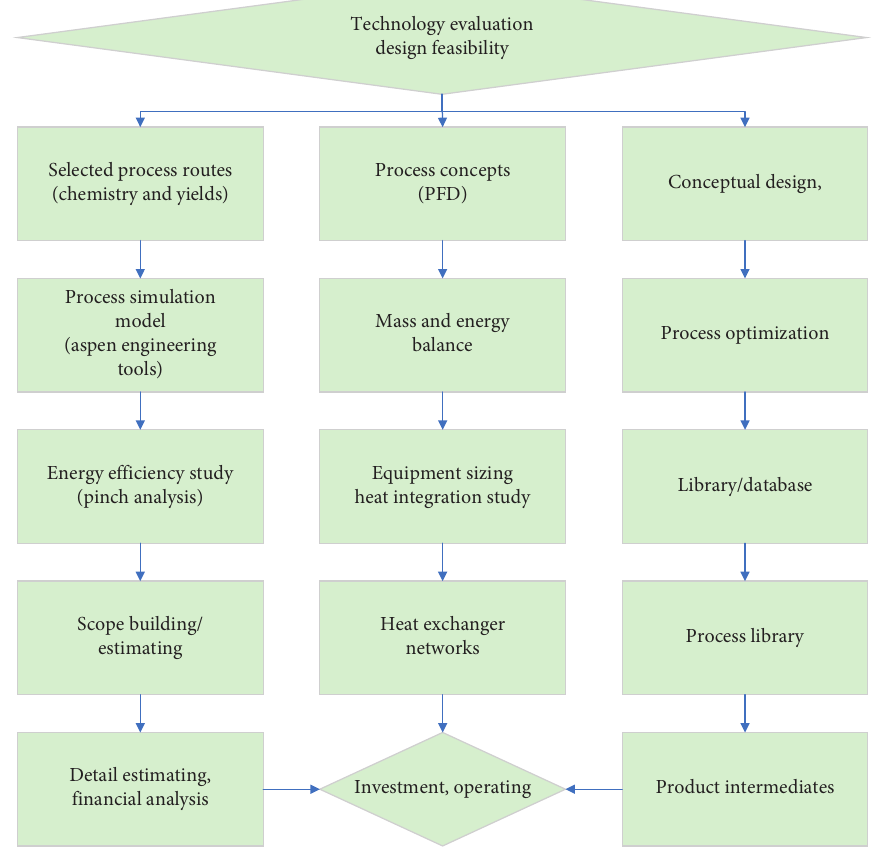
Figure 4: Performance design framework.